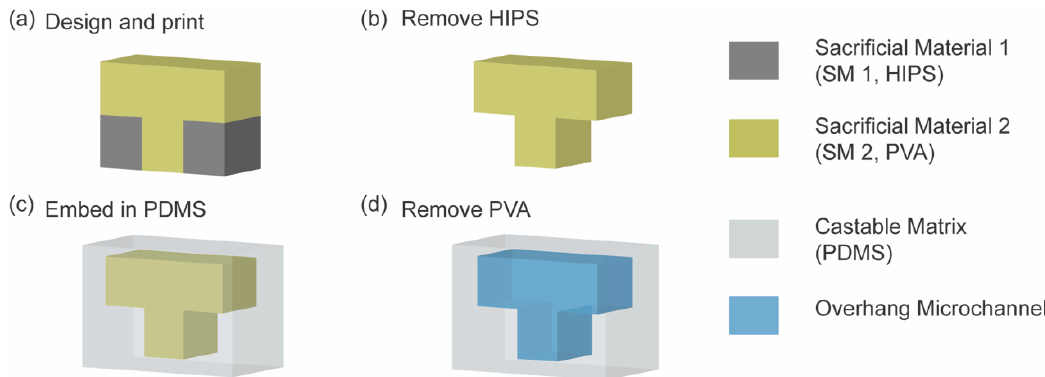
Figure 1. Schematic illustrations of dual sacrificial molding of HIPS and PVA to fabricate microchannels with an overhang or helical features in a castable matrix. The process of dual sacrificial molding can be divided into two major phases: (1) removal of Sacrificial Material 1 (HIPS, grey) ( a , b ), and (2) removal of Sacrificial Material 2 (PVA, pale yellow) ( c , d ). ( a ) An overhang pattern was printed by dual extrusion of HIPS and PVA. HIPS was used as a support material during FDM printing; ( b ) HIPS was removed in limonene, and the PVA sacrificial mold was obtained; ( c ) The PVA sacrificial mold, containing the overhangs, was embedded in PDMS; ( d ) PVA was removed in an ultrasonic water bath, and microchannels with overhangs were obtained.